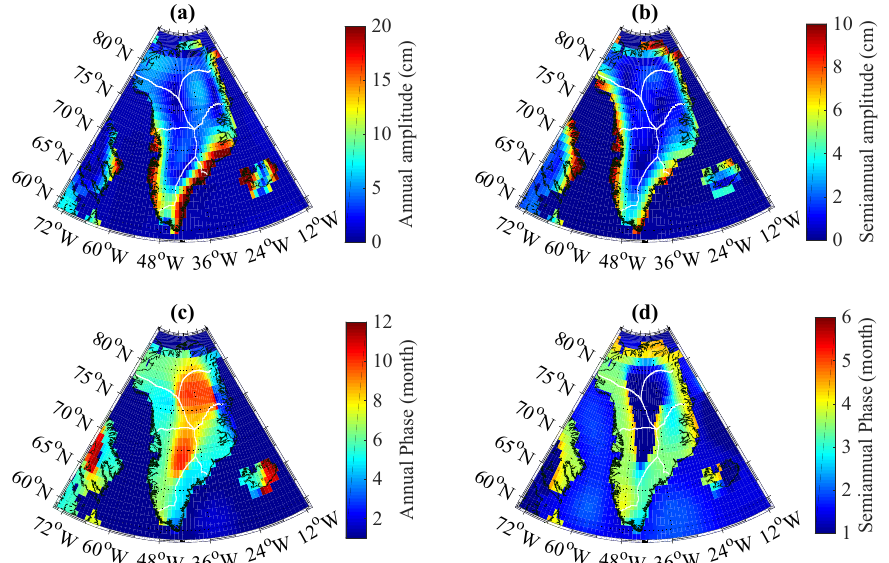
Figure 5. Seasonal mass changes estimated based on averaging the GRACE monthly solutions from four processing centers between April 2002 and June 2017 and after applying the forward modeling technique to suppress the ocean-land leakage effect: ( a ) annual amplitude, ( b ) semi-annual amplitude, ( c ) annual phase, and ( d ) semi-annual phase.